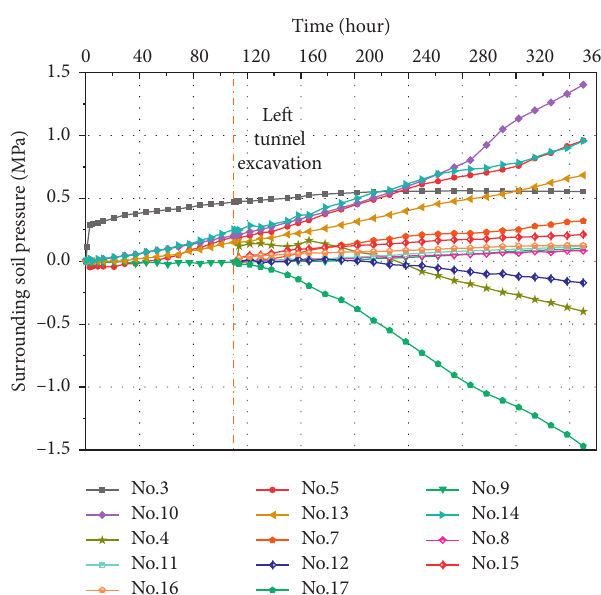
Figure 9: Stress history curve of surrounding shoulder of the right tunnel exhibited the largest reduction in the surrounding rock pressure (1.4 MPa), followed by measuring point No. 14 on the crown of the right tunnel (0.96 MPa); the other measuring points exhibited relatively small reductions in the surrounding rock pressure. This indicates that under the Level II rock condition, the sur- rounding rock loosening range caused by tunnel excavation construction could still exceed 0.5 D .